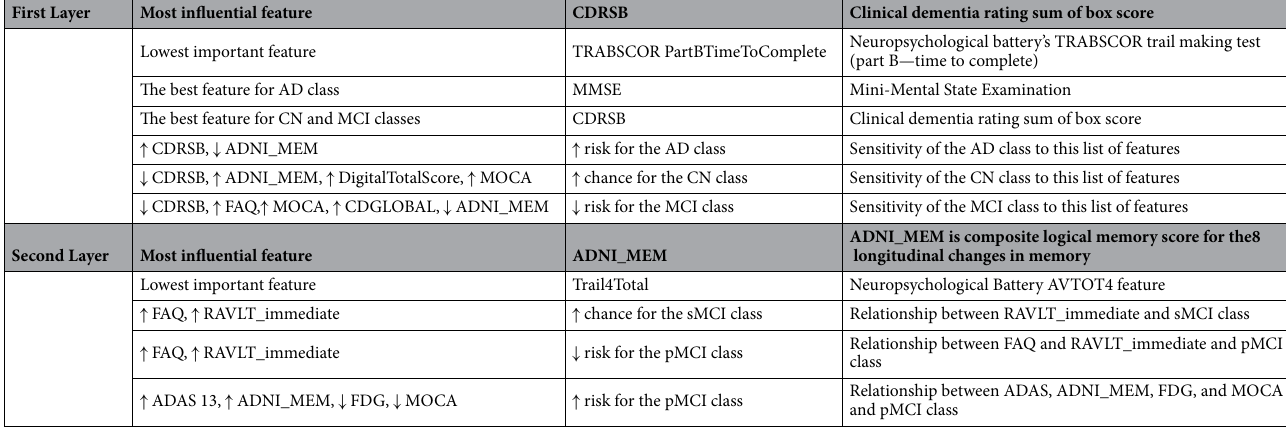
Table 8. Examples of the relationship between features and class prediction.